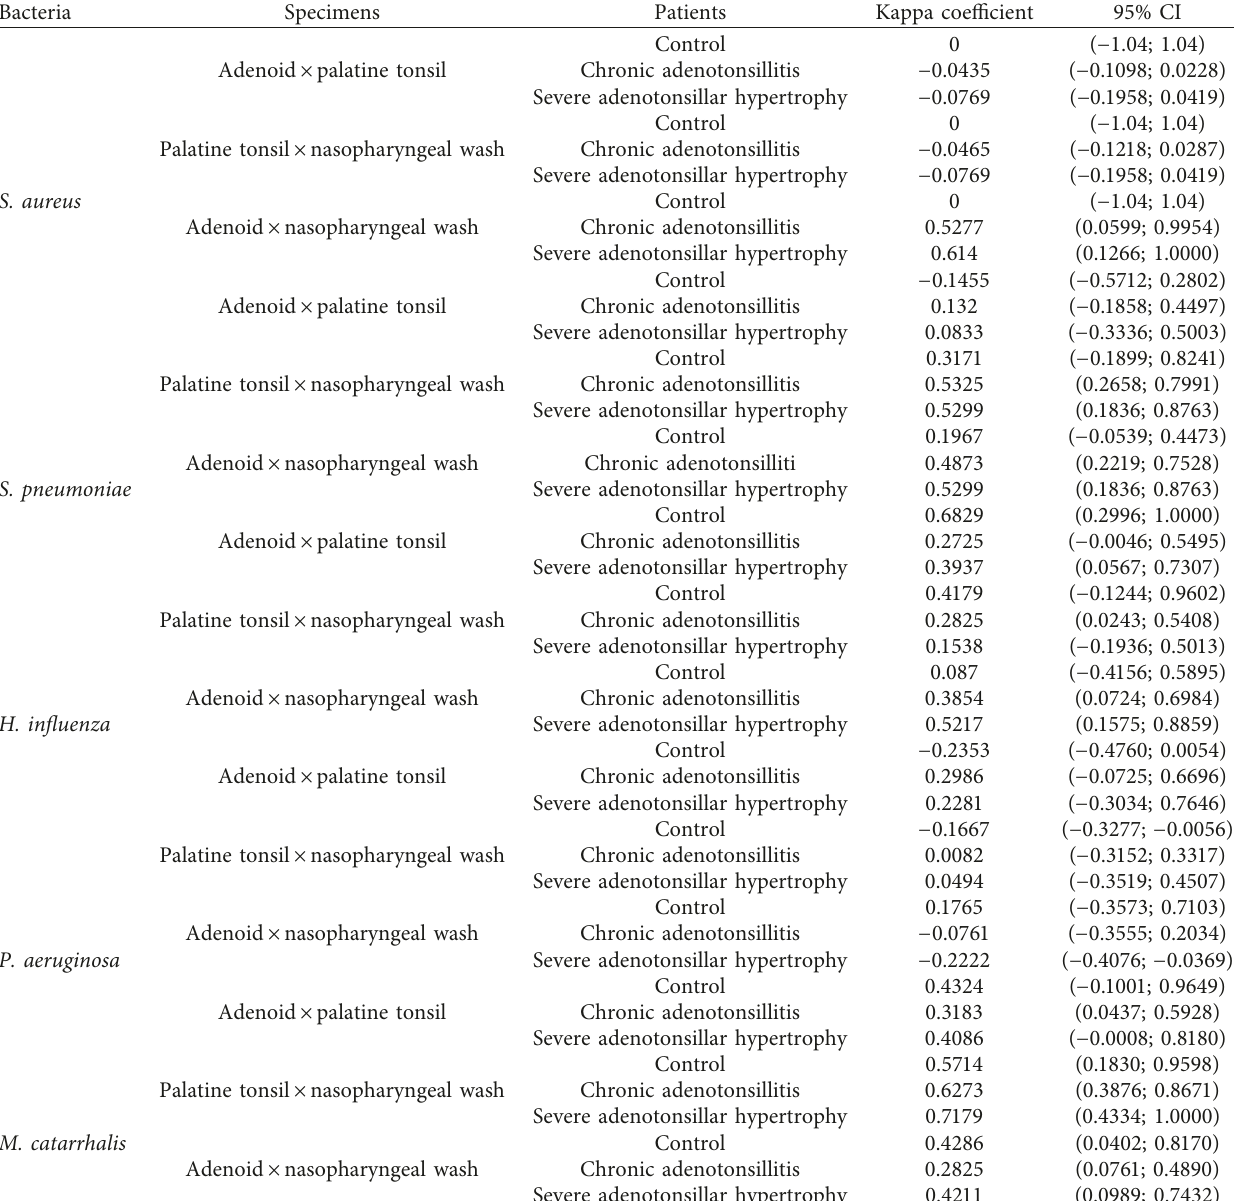
Table 3: Analyses of agreement of bacteria detection rates among different specimens collected from patients with chronic adenotonsillitis, severe adenotonsillar hypertrophy, and